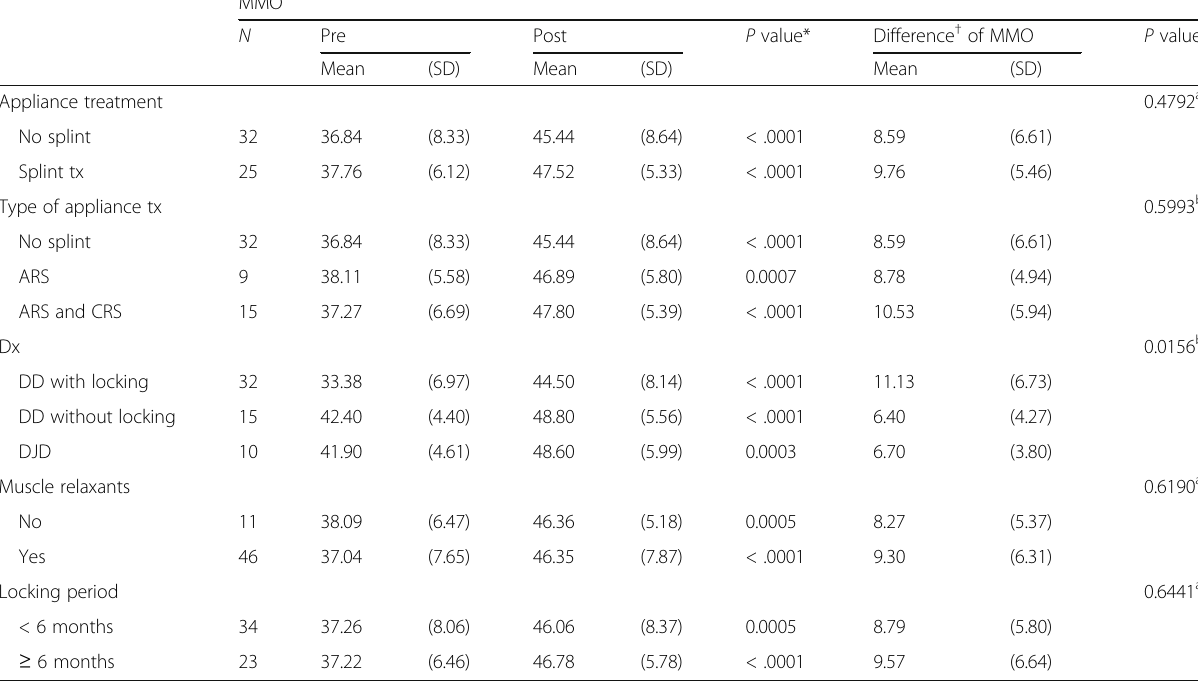
Table 4 Improvement in MMO due to various